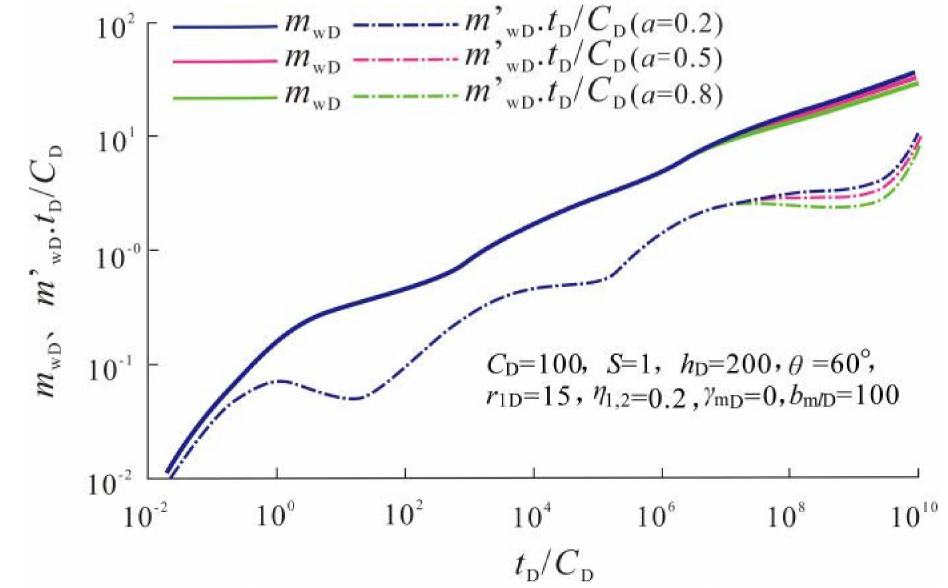
Figure 4. Effect of the nonlinear parameter on dynamic pseudo pressure